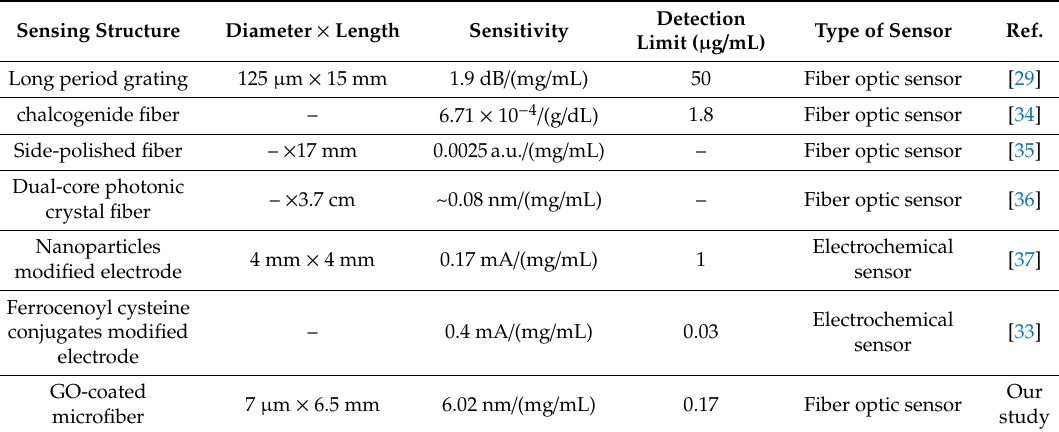
Table 1. Comparison of sensing performance between di ff erent Hb